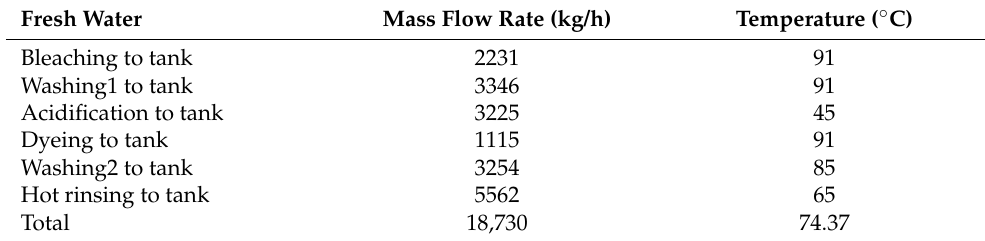
Table 3. Flow rate and temperature of heat-recovered freshwater (Case 1).